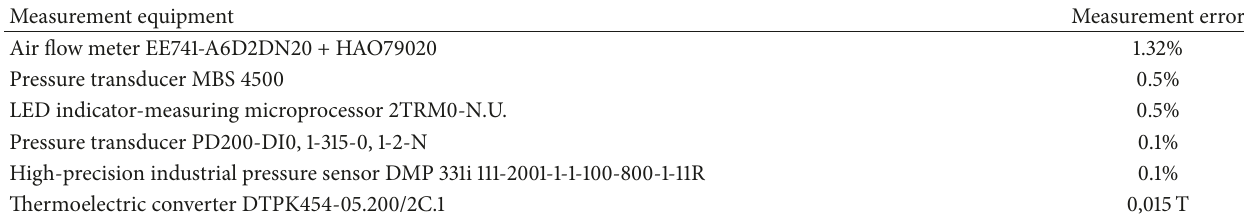
Figure 3: Experimental facility diagram. Table 1: Accuracy of the measurement